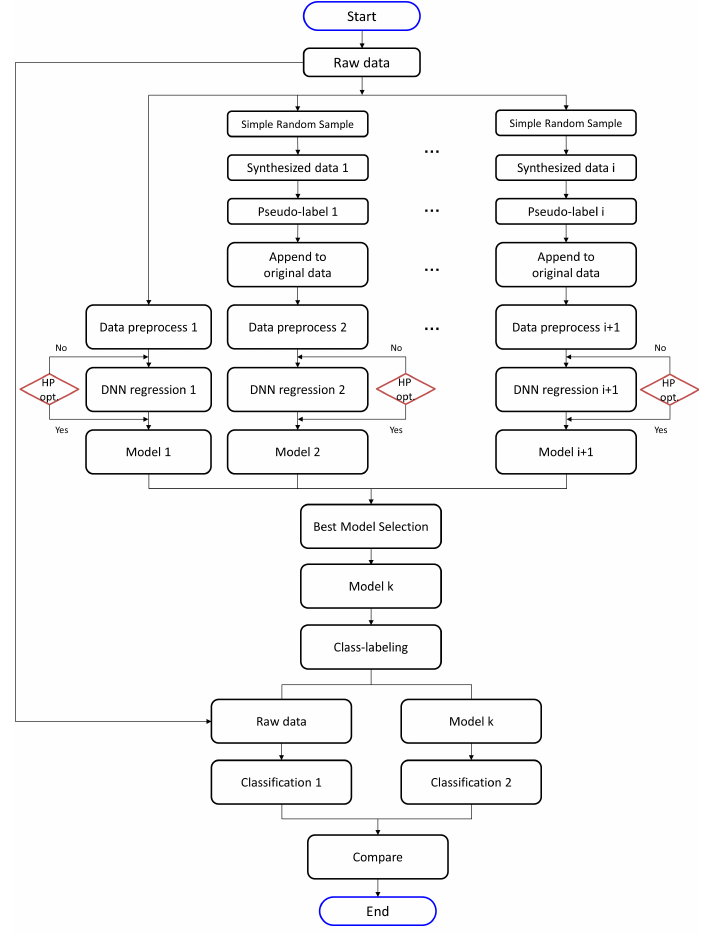
Figure 4. Experimental workflow illustrating the overall